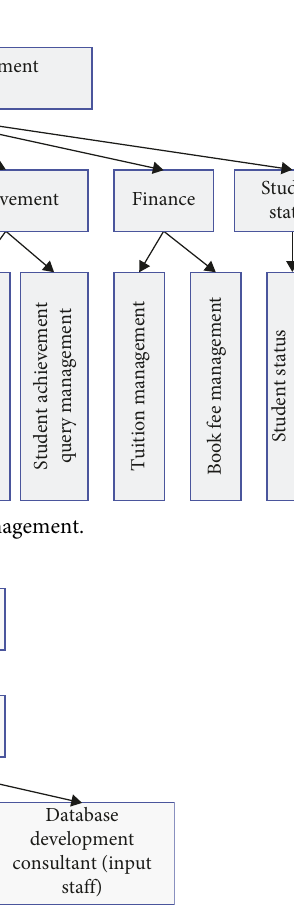
Figure 2: Organizational structure of teaching management informatization project.